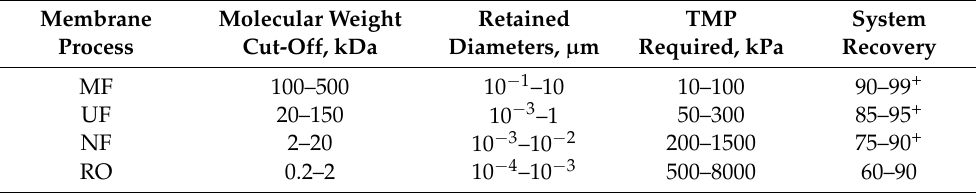
Table 6. Key features of pressure-driven membrane filtration processes. Adapted from [100,102].